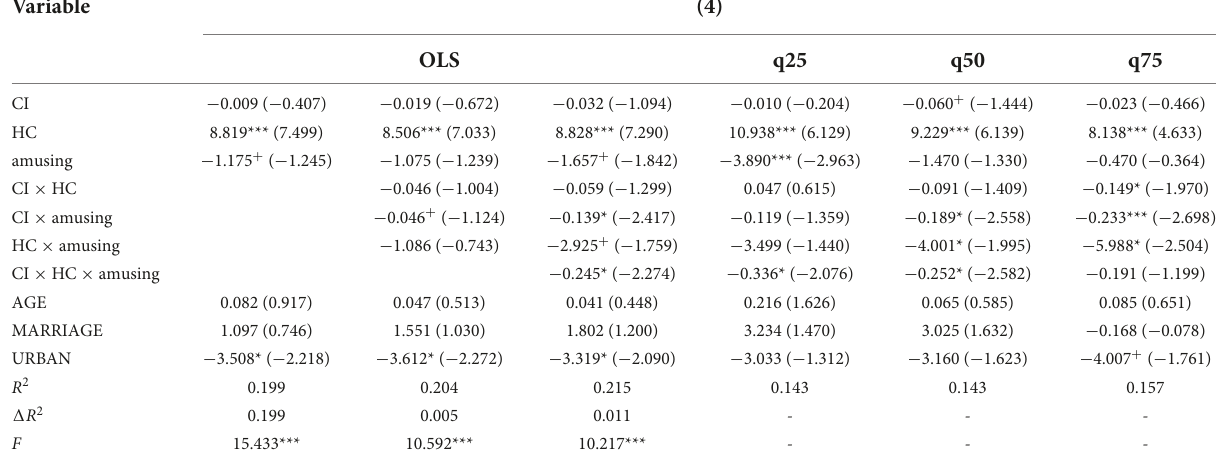
TABLE 7 Analysis of the secondary moderating impact of amusing-oriented new media use.